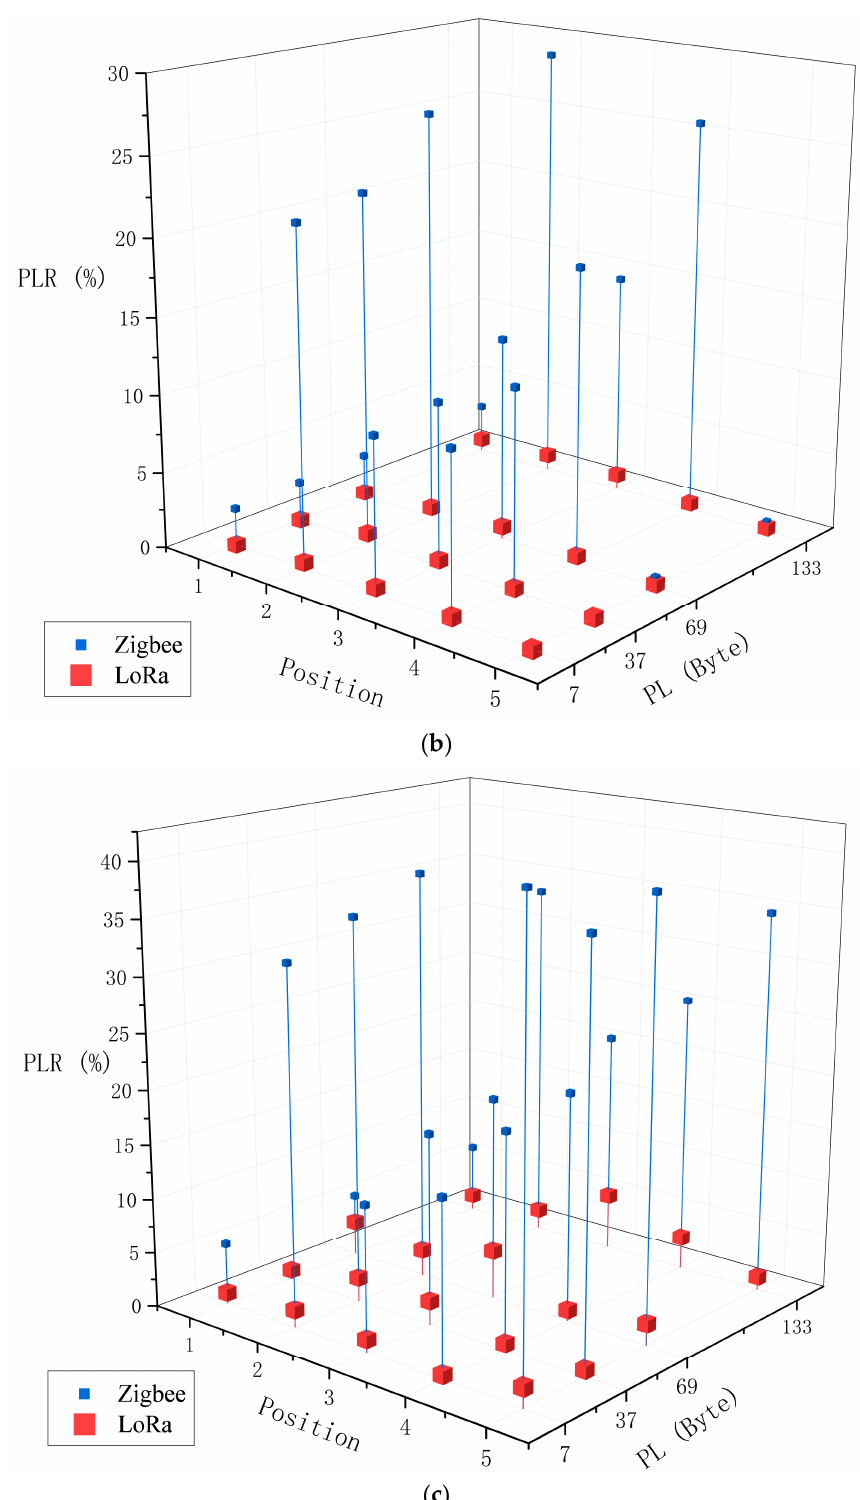
Figure 10. PLR in horizontal experiment: ( a ) Baud = 1200 bps; ( b ) Baud = 9600 bps; ( c ) Baud = 115,200 bps.